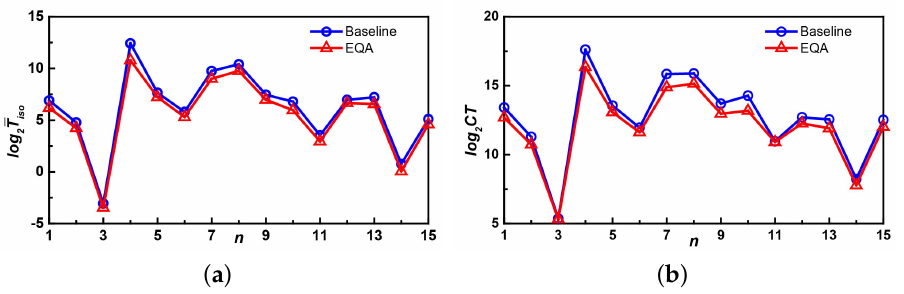
Figure 12. Comparison results on the HPRD dataset. ( a ) The comparison of T iso ; ( b ) the comparison of CT